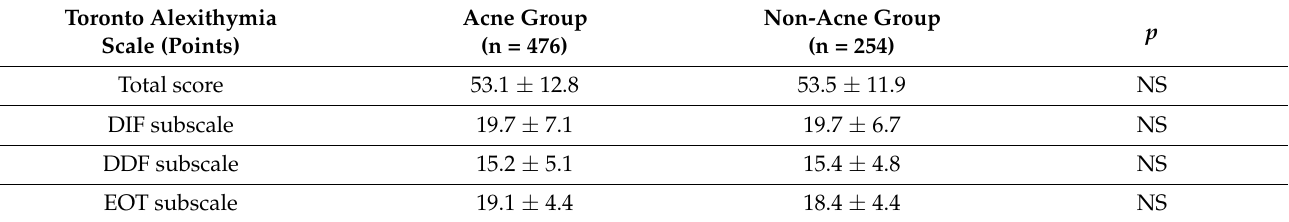
Table 2. Alexithymia in pupils with and without acne.